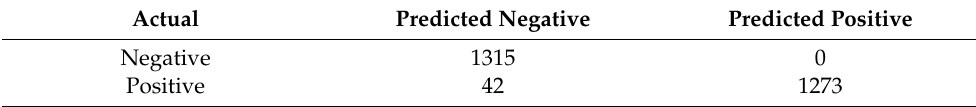
Table 17. Confusion matrix for J48 DT model (testing).